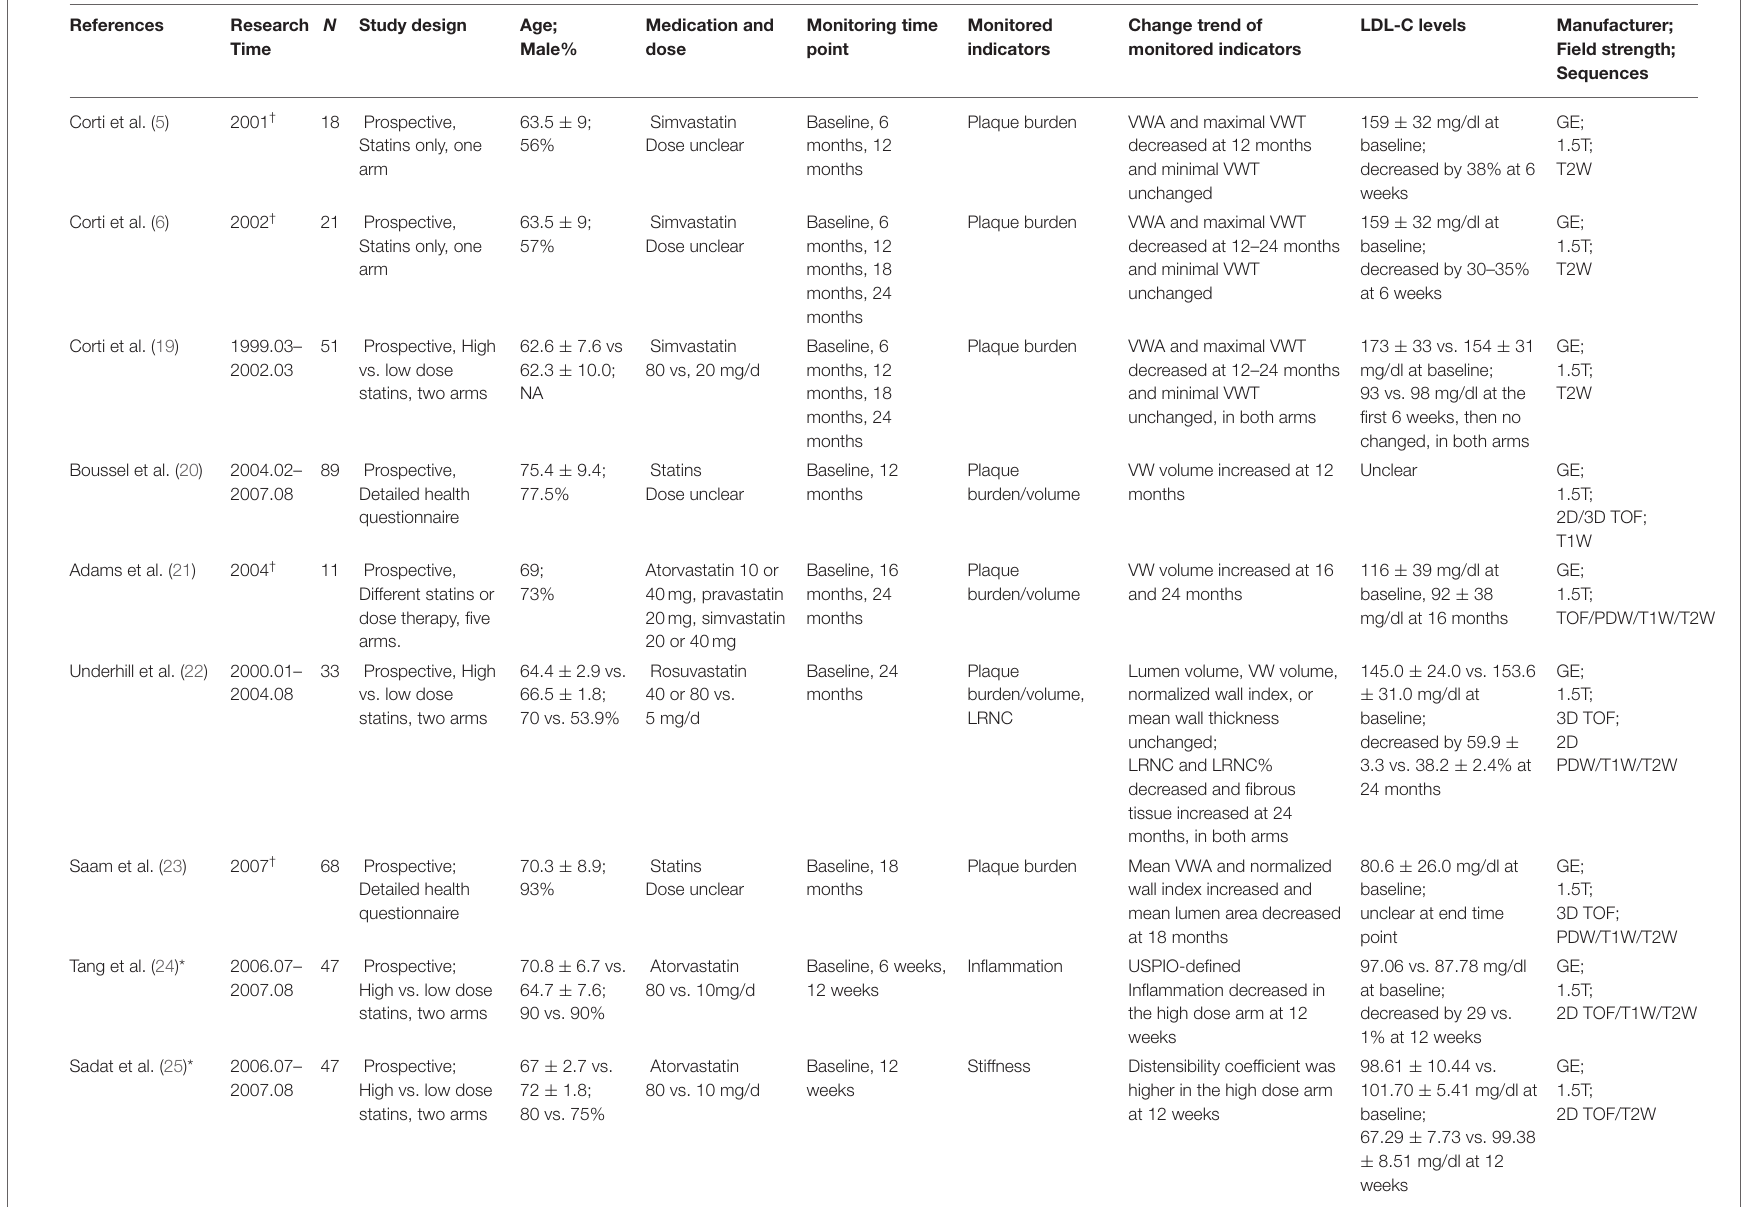
TABLE 1 | Serial vessel wall MRI studies on effects of statin therapy on extracranial carotid